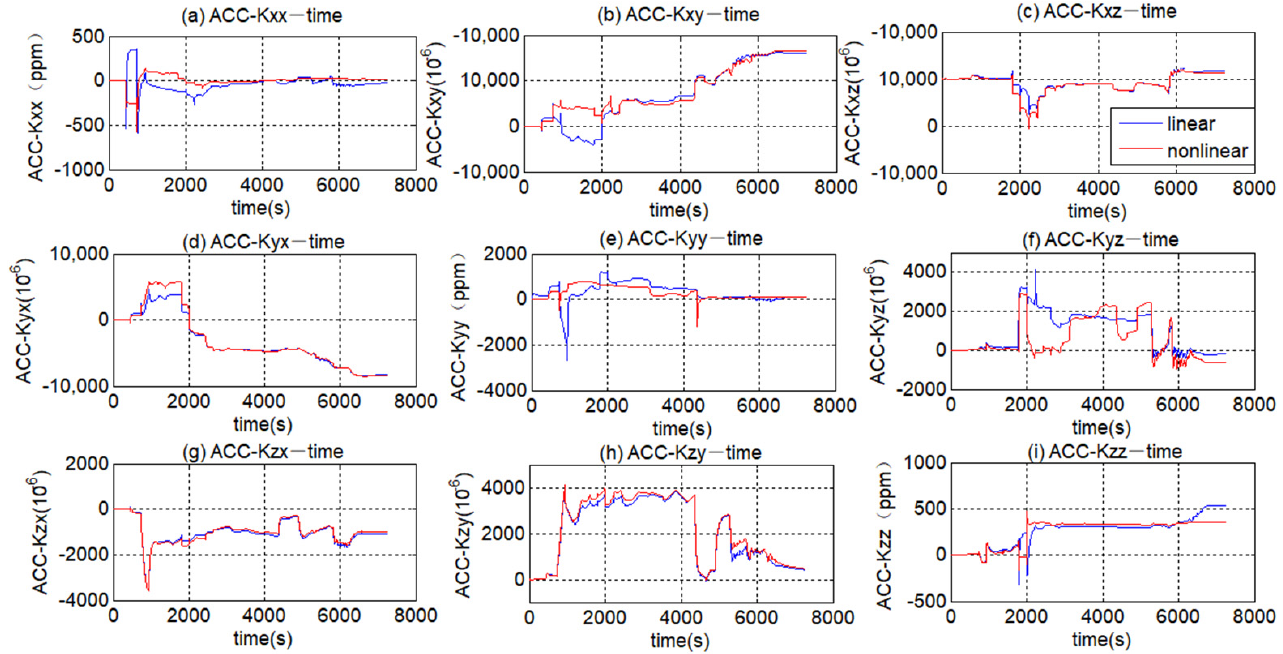
Figure A2. Estimated results of the scale factor error and misalignment error